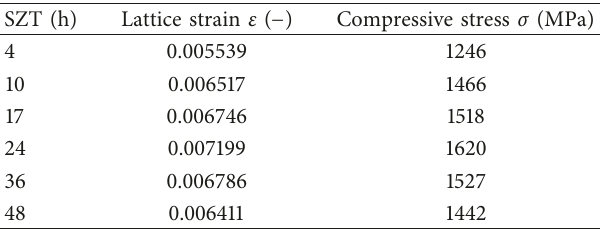
Table 2: Compressive stress σ (MPa) in the specimen SZT for various